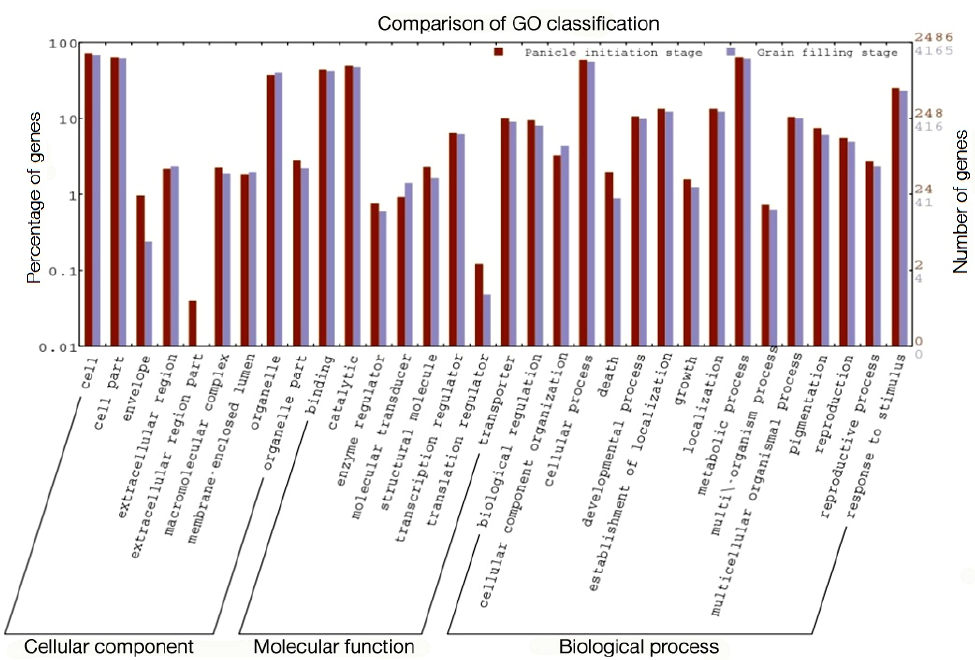
Figure 3. Kyoto Encyclopedia of Genes and Genomes (KEGG) pathway incident of panicle initiation and grain filling stage in Ajay hybrid. Figure 4. KEGG pathway incident of panicle initiation and grain filling stage in Rajalaxmi hybrid.